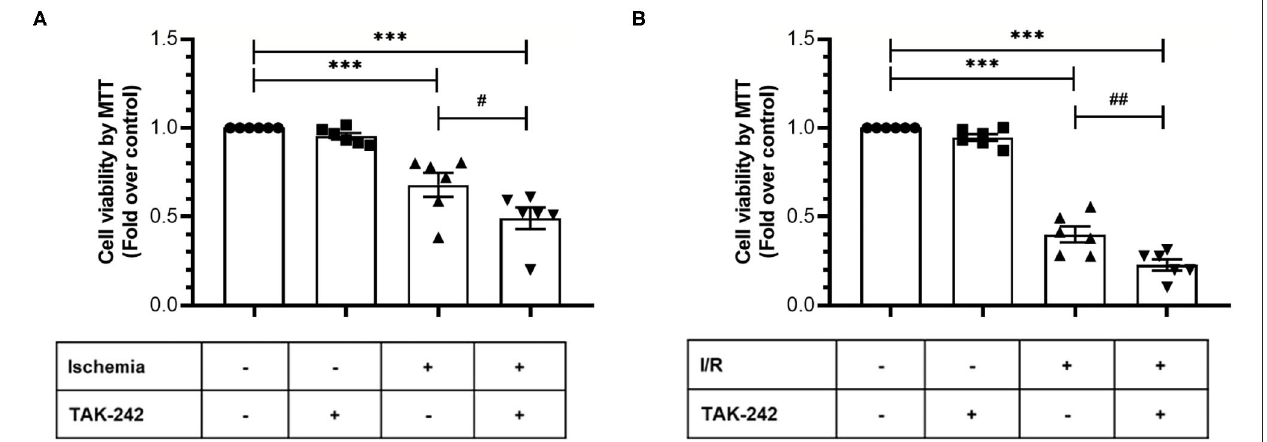
FIGURE 4 | Blockade of TLR4 increases the loss of cardiac fibroblasts viability induced by ischemia or ischemia/reperfusion (I/R). Cardiac fibroblasts were treated with the specific TLR4 inhibitor TAK-242 (4 µ M) during the 8h of ischemia (A) or during the 8h of ischemia and the 16h of reperfusion (B) . Cell viability was determined using the MTT assay. Results are expressed as mean ± SEM of six independent experiments. *** p < 0.001 vs. control; # p < 0.05 vs. ischemia; ## p < 0.01 vs.